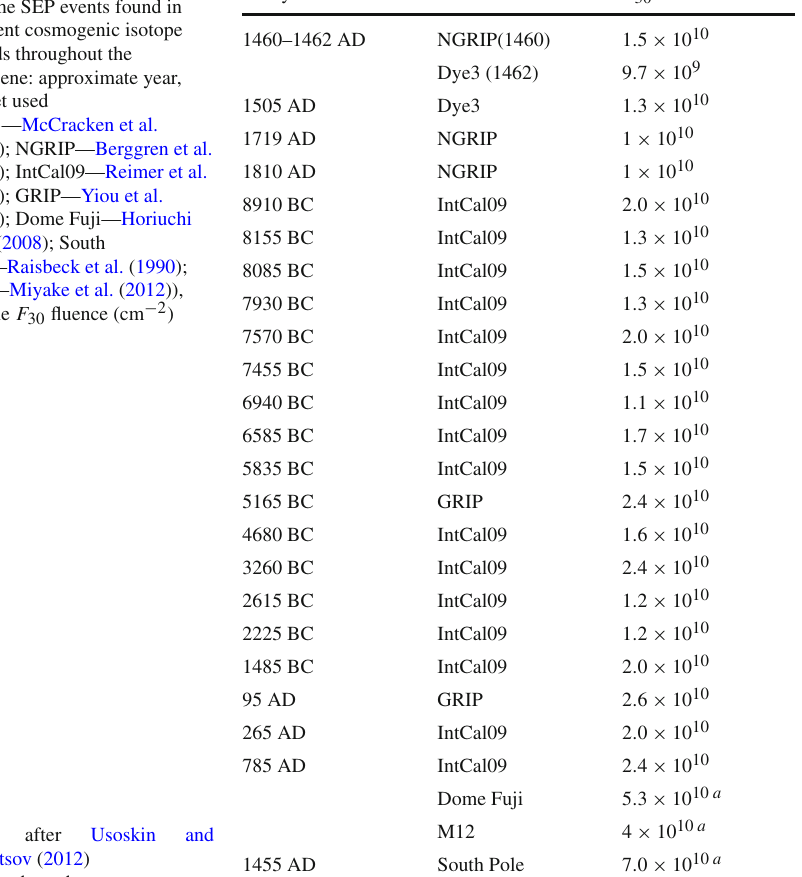
after Usoskin and Kovaltsov (2012) a Upper